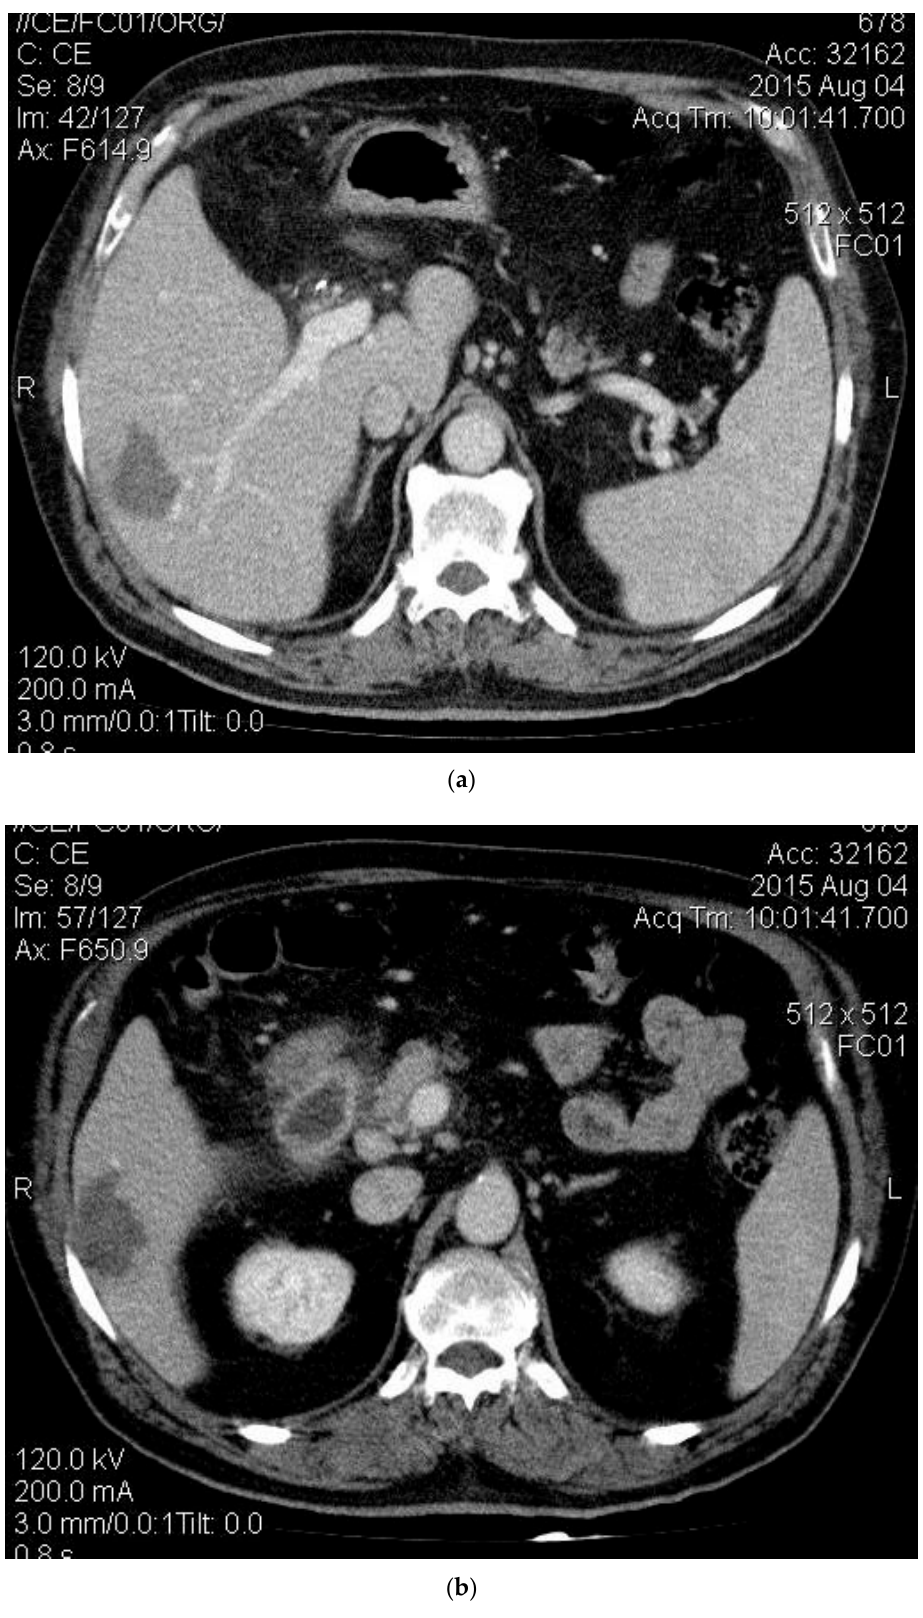
Figure 4. ( a ) The complete ablation of mass 1; ( b ) The complete ablation of mass 2.